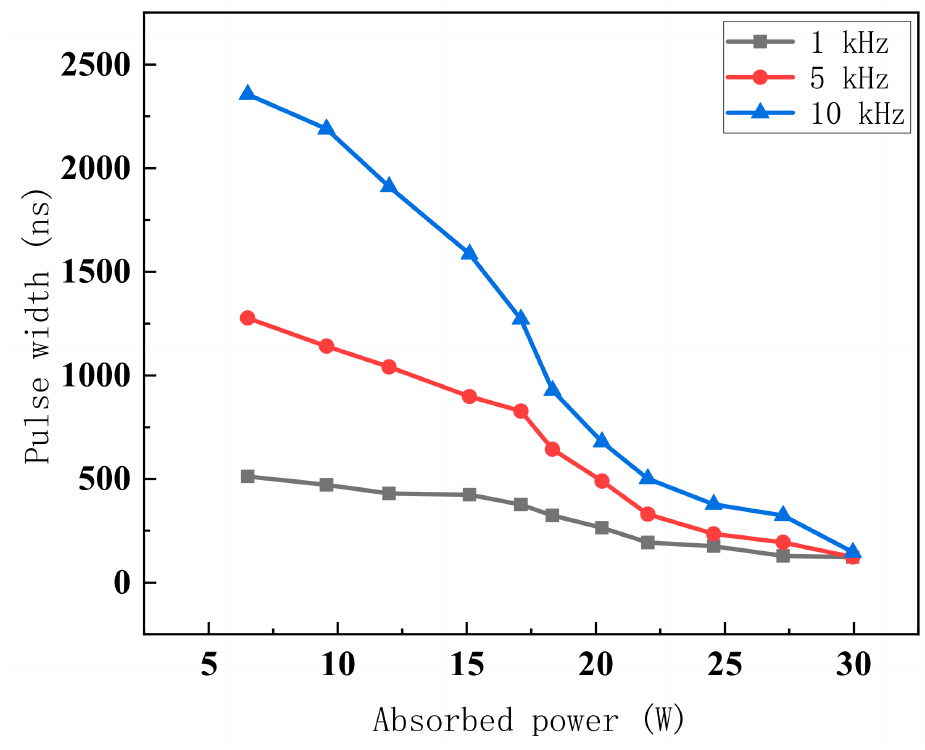
Figure 6. Output pulse width of Q-switched Ho:YAP laser versus absorbed power. The central wavelength of the AO Q-switched Ho:YAP laser was measured using